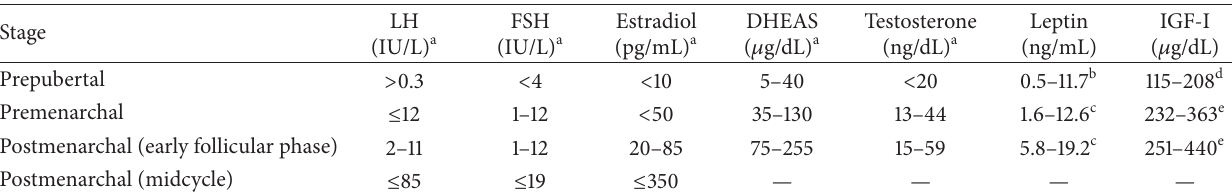
Table 1: Approximate values for serum levels of various endocrine mediators at distinct stages in the physiologic life course of female reproductive